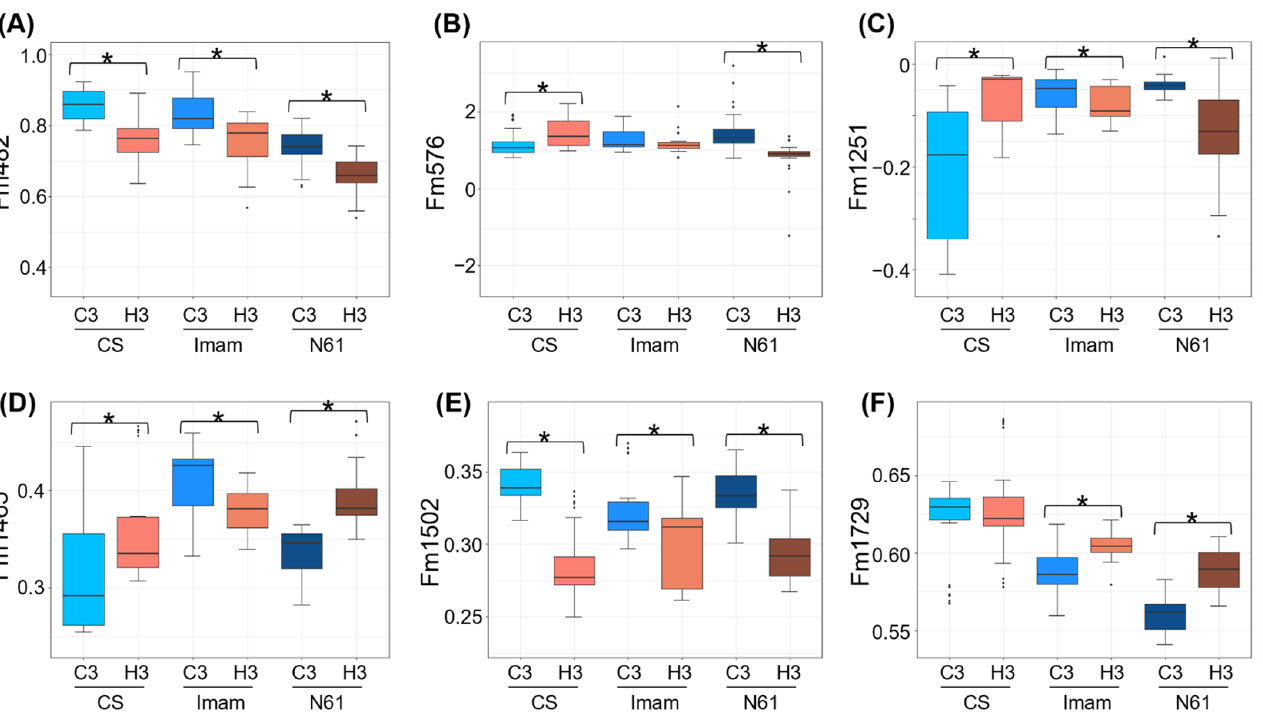
Figure 4. Comparison of FTIR-based biomarkers under heat stress between the three genotypes tested. Boxplots for ( A ) Fm482, ( B ) Fm576, ( C ) Fm1251, ( D ) Fm1465, ( E ) Fm1502, and ( F ) Fm1729 are shown for CS, Imam, and N61 genotypes under C3 and H3 environments. The 36 spectra included each genotype–environment combination. Asterisks represent statistically significant differences at p < 0.01.